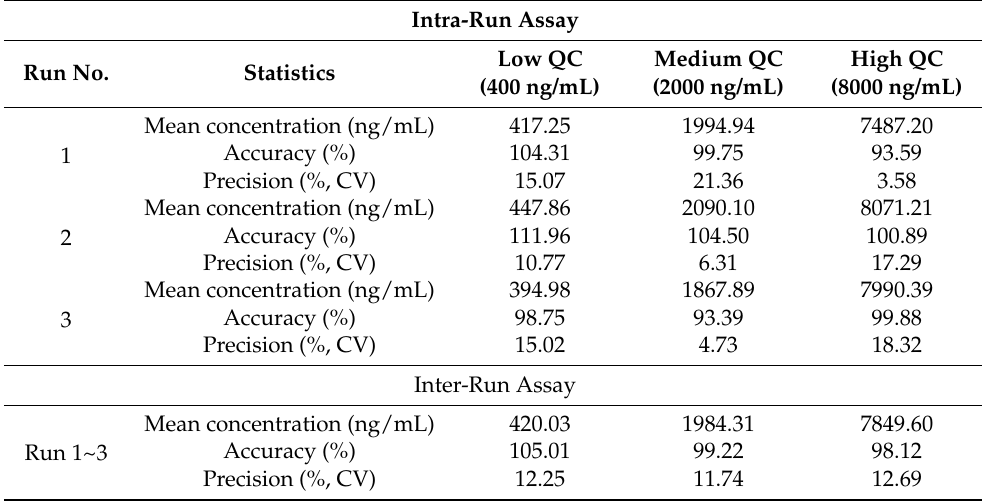
Table 1. Intra/inter-day accuracy and precision of MAC glucuronide phenol linked SN-38 in quality control samples at three levels ( n = 3 for intra-day accuracy and precision; n = 9 for inter-day accuracy and precision).